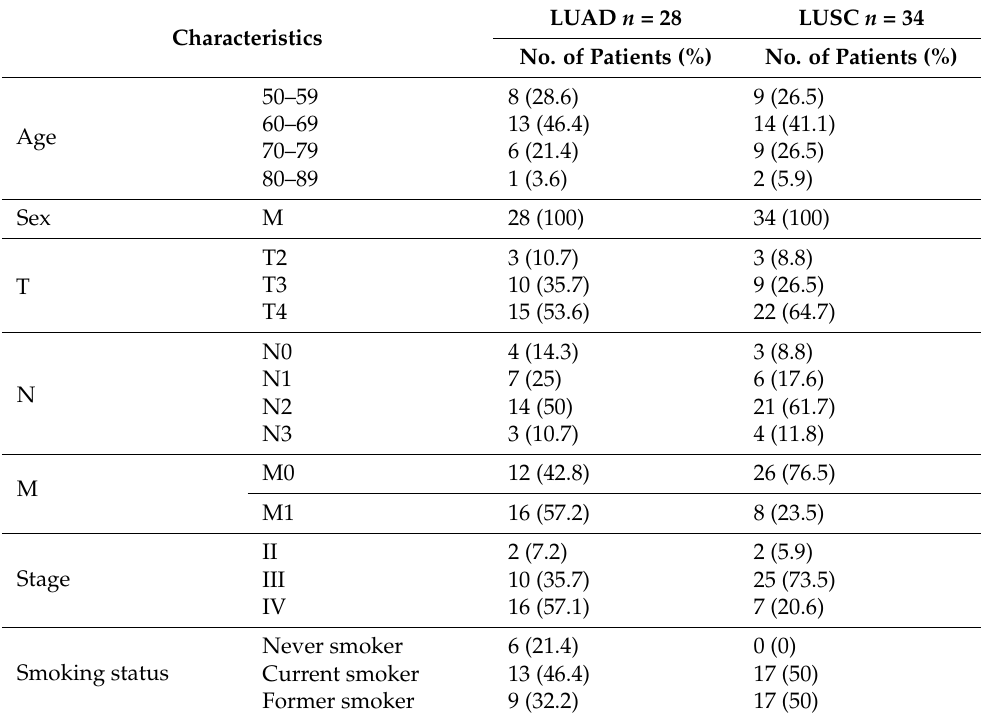
Table 3. Clinicopathological characteristics of the 62 NSCLC samples used for the miRNA expression validation with qRT-PCR validation.